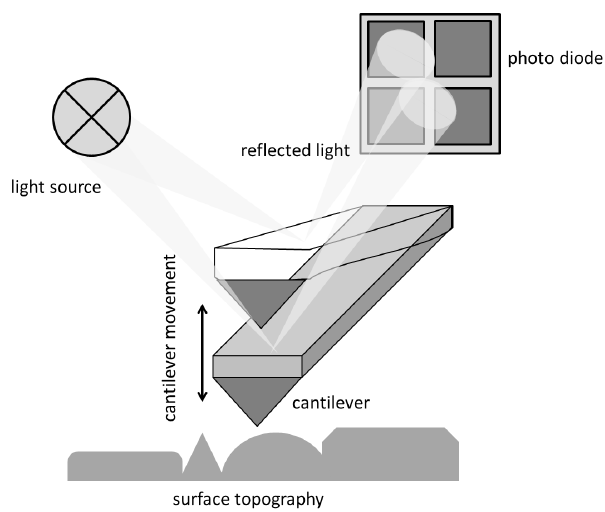
Figure 12. AFM equipment (adapted from [77]).